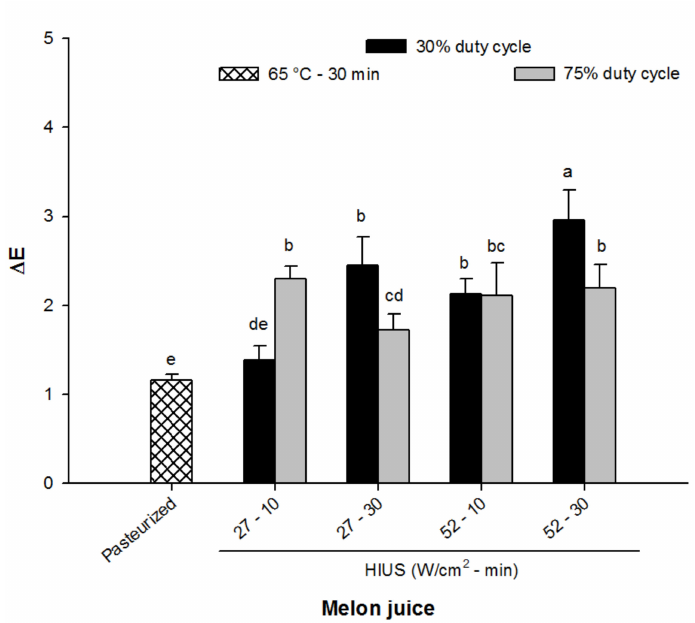
Figure 2. Color change of pasteurized and HIUS processed melon ( Cucumis melo ) juice. Different letters above the bars indicate statistical difference in treatments ( p < 0.05) ( n = 3).